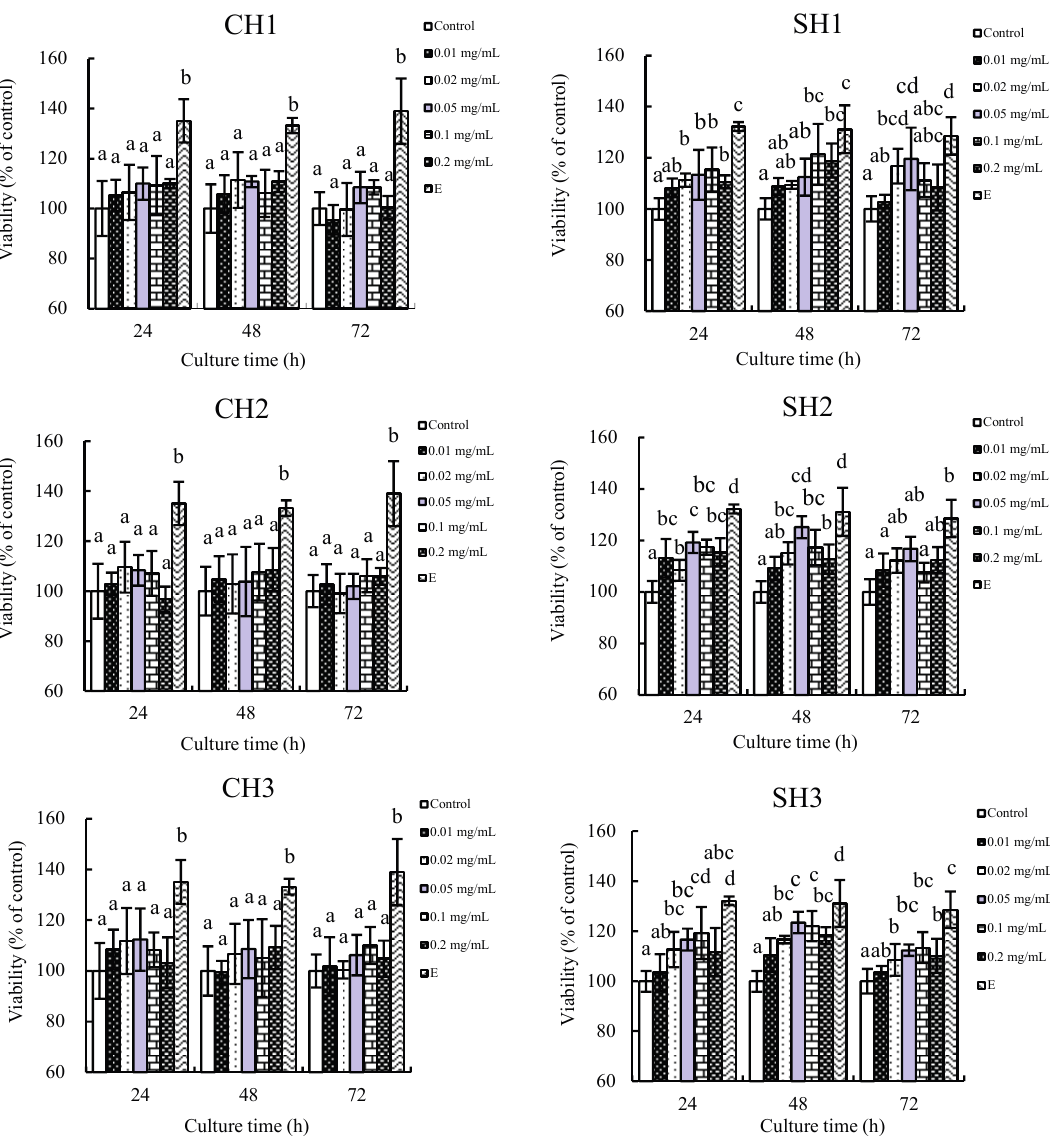
Figure 1. Proliferation of casein and soy protein hydrolysates (CH1–3 and SH1–3) on hFOB1.19 cells cultured for 24, 48 and 72 h, respectively. E denotes 17 β -estradiol. CH1–3 denote casein hydrolysates with DH values of 7.3%, 10.8% and 13.3%, while SH1–3 denote soy protein hydrolysates with DH values of 7.5%, 10.9% and 13.2%, respectively. Different lowercase letters above the columns indicate that the mean values of different groups are significantly different ( p <